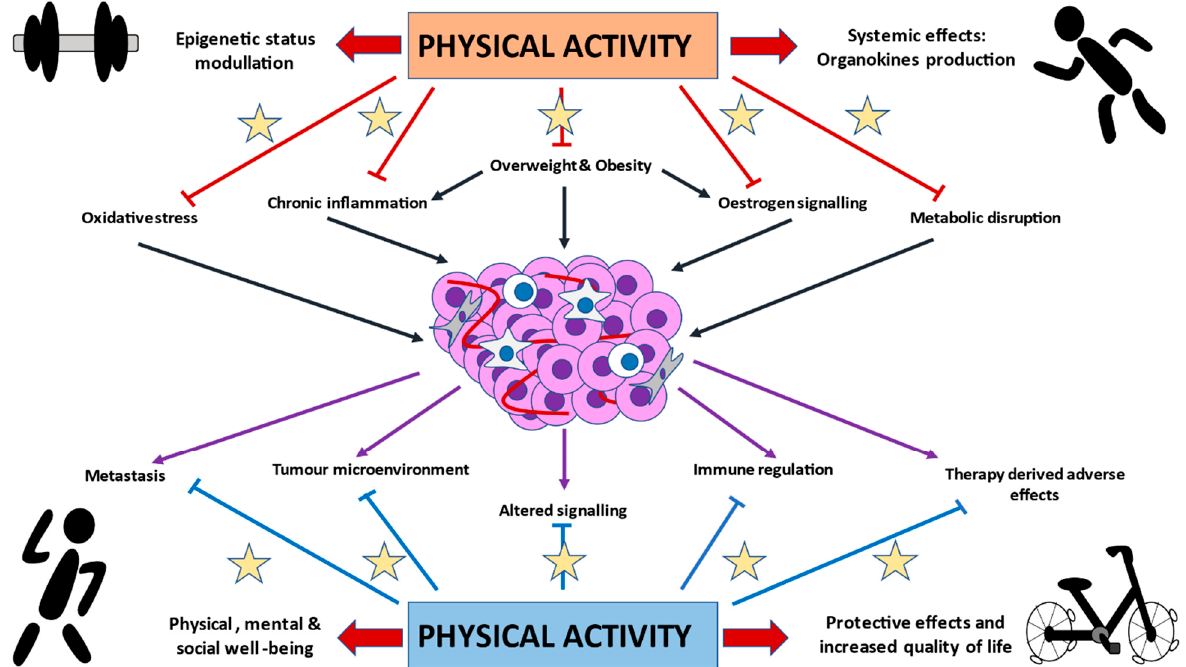
Figure 1. Graphical representation of the potential effects of physical activity (PA) in breast cancer (BC). As it is appreciated, PA may play a prominent role in the prevention of BC through its effects in important carcinogenic drivers, including oxidative stress, chronic inflammation, overweight/obesity, estrogen, and dysmetabolism. The main mechanisms are derived from epigenetic modulatory properties of PA and its systemic effects, including the production of organokines (such as myokines, adipokines, batokines, hepatokines, etc.). On the other hand, once BC is established, PA may also confer substantial benefits for BC patients, through its inhibitory effects on metastasis, molecular signaling, immune dysregulation, or tumor-favoring microenvironment. What is more, PA represents a potential tool to reduce therapy-derived adverse effects, due to its protective capacities and role in the physical, mental, and social well-being, leading to an increased quality of life of BC patients.